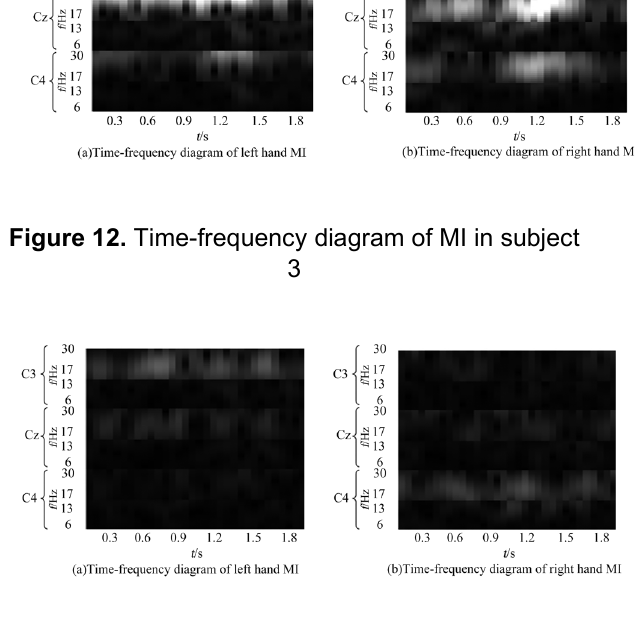
Figure 13. Time-frequency diagram of MI in subject 4